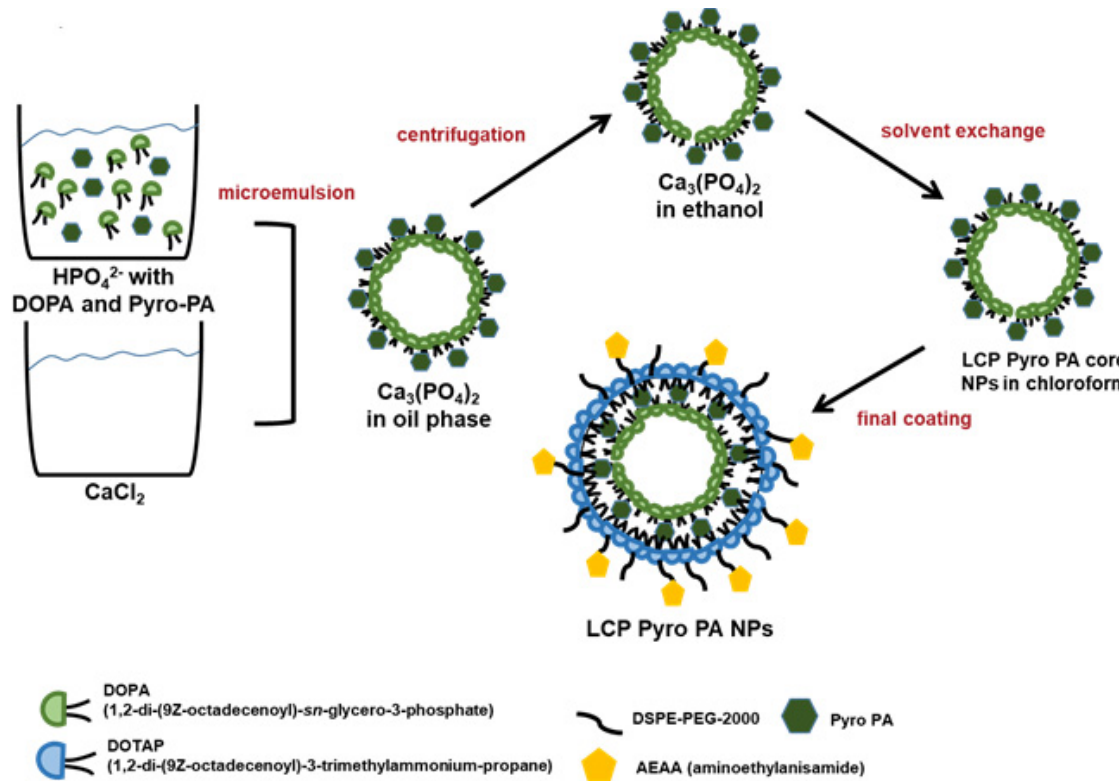
Figure 2 . Novel synthesis method of LCP Pyro-Pa nanoparticles. LCP Pyro-Pa NP was composed of a biodegradable calcium phosphate core stabilized using DOPA and DOTAP. The outer layer of lipid was modified with polyethylene glycol (PEG) chains and aminoethylanisamide.